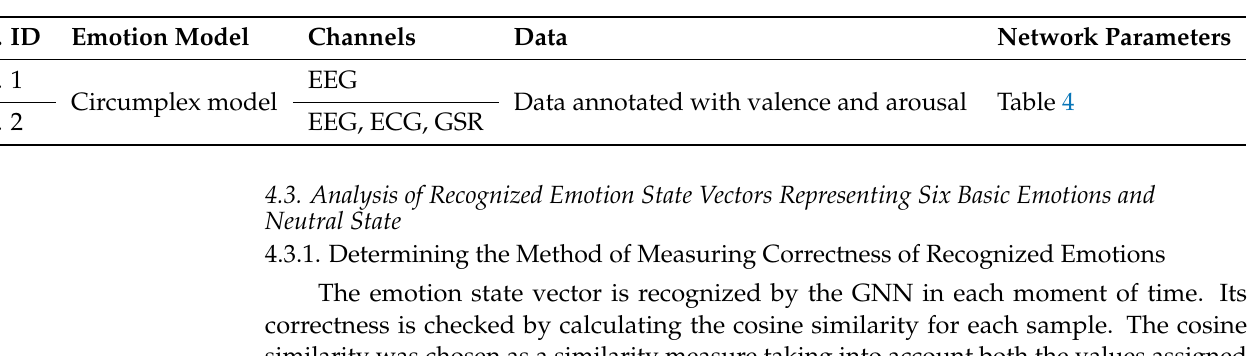
Table 8. Experiments specification for analysis of accuracy of recognized quadrant in Circumplex